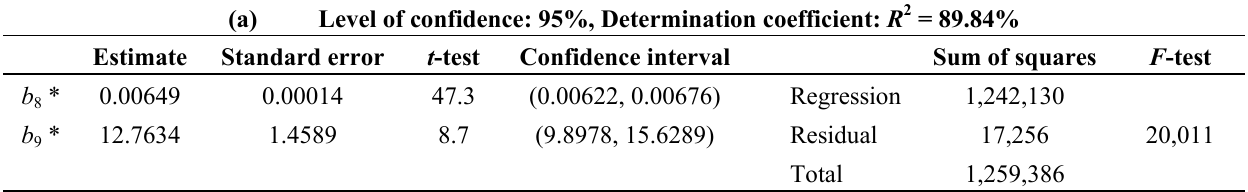
Table 5. Estimation of empirical regression coefficients and analysis of variance of model (5a), ( a ) no recirculation; ( b ) recirculation 16.5%; ( c ) recirculation